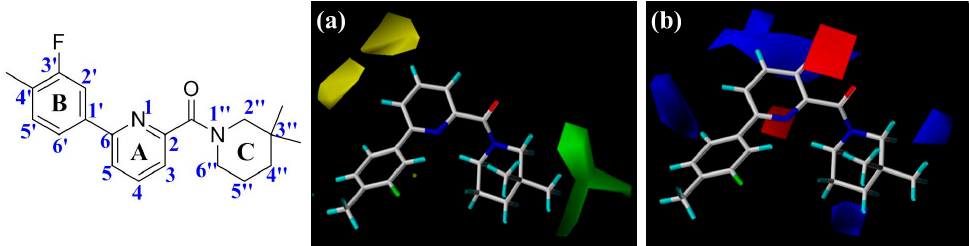
Figure 2. The contour maps of CoMFA model based on compound 1 (color figure online). ( a ) Steric field: green and yellow contours indicate regions where bulky groups increase and decrease activity. ( b ) Electrostatic field: red and blue contours indicate regions where negative charge increase and decrease activity.